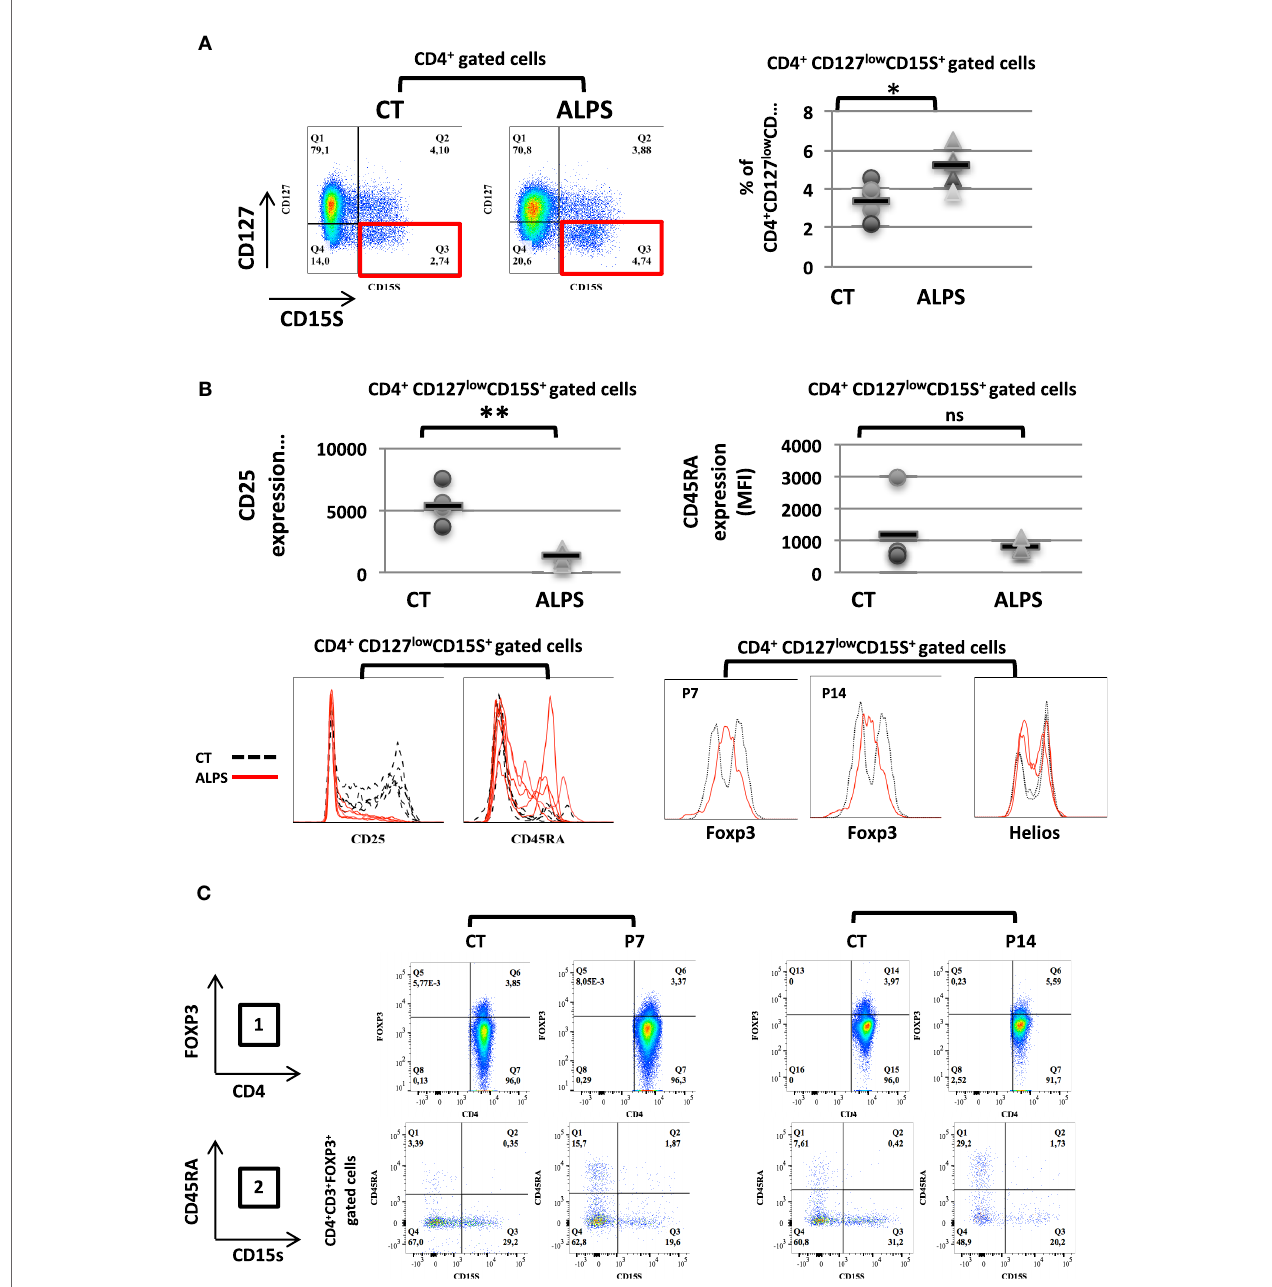
FigUre 3 | Proportion and phenotype of CD127 low CD15s + regulatory T cell (Treg) subpopulations in autoimmune lymphoproliferative syndrome (ALPS) patients. (a) CD3 + CD4 + -gated T lymphocytes isolated from four healthy controls (CTs) or five ALPS patients (ALPS) were stained for CD15S and CD127. The mean ± SD (range) percentage of CD127 low CD15s + T cells subpopulation was 5.1 ± 0.4% (3.75–6.51%) in ALPS patients and 3.3 ± 0.4% (2.01–4.4%) in CTs is shown. (b) CD4 + CD127 low CD15s + -gated T cell subpopulations were stained for CD25, CD45RA, FOXP3, and Helios. The staining of FOXP3 and Helios was shown for two patients (P7 and P14) and two of the four CTs (left panel). The results for CD25, CD45RA in the CD4 + CD127 low CD15s + T cell subpopulation are shown. For CTs (dashed black lines), the mean ± SD fluorescence intensities were 6,011 ± 1,950 (CD25) and 1,225 ± 1,048 (CD45RA). For ALPS patients (solid red lines), the mean ± SD fluorescence intensities were 1,299 ± 491 (CD25) and 761 ± 164 (CD45RA). (** p = 0.0029, * p = 0.0124, ns: not significant). (c) The expression of CD4 and FOXP3 was shown on CD3 + CD4 + -gated cells for two CTs, and two patients (P7 and P14) are shown in panel 1. The percentage of CD15s + CD45RA neg cells on CD3 + CD4 + FOXP3 + -gated cells is shown for two patients (P7 and P14) and two controls (CT) (panel 2). Statistical analyses were performed using a non-parametric Mann–Whitney U